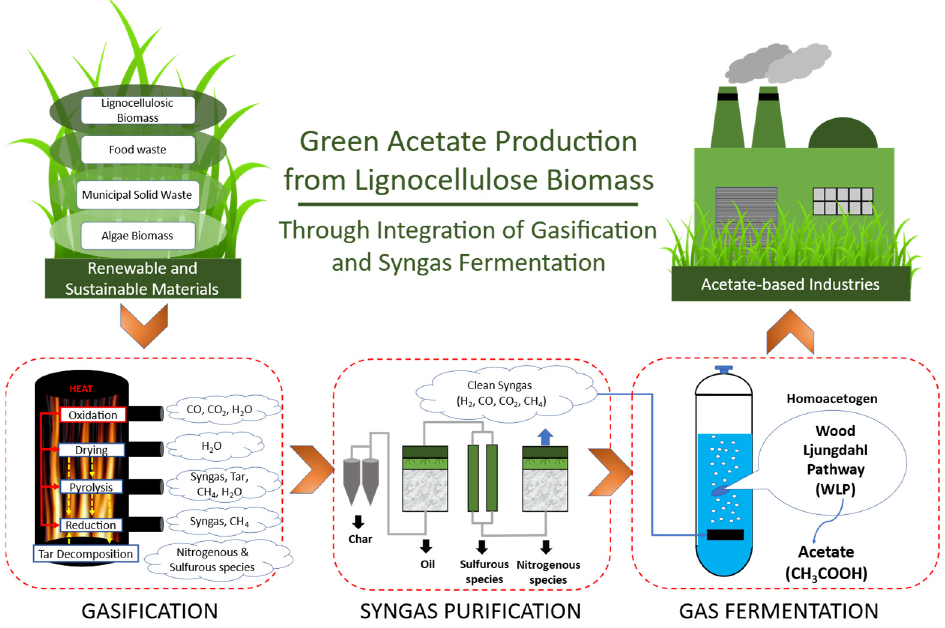
Figure 1. Acetate production through gasification of lignocellulosic biomass materials followed by syngas fermentation.